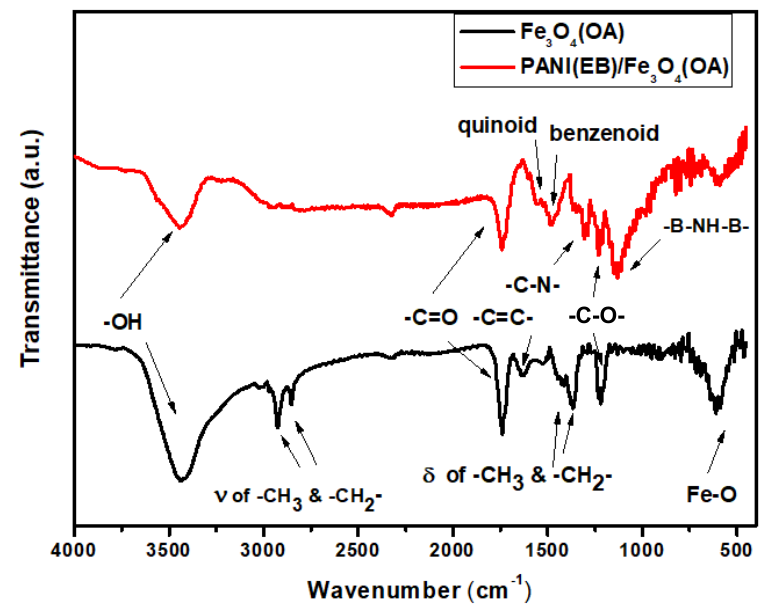
Figure 1. FTIR - spectra of neat Fe 3 O 4 (OA) and PANI(EB)/Fe 3 O 4 (OA)